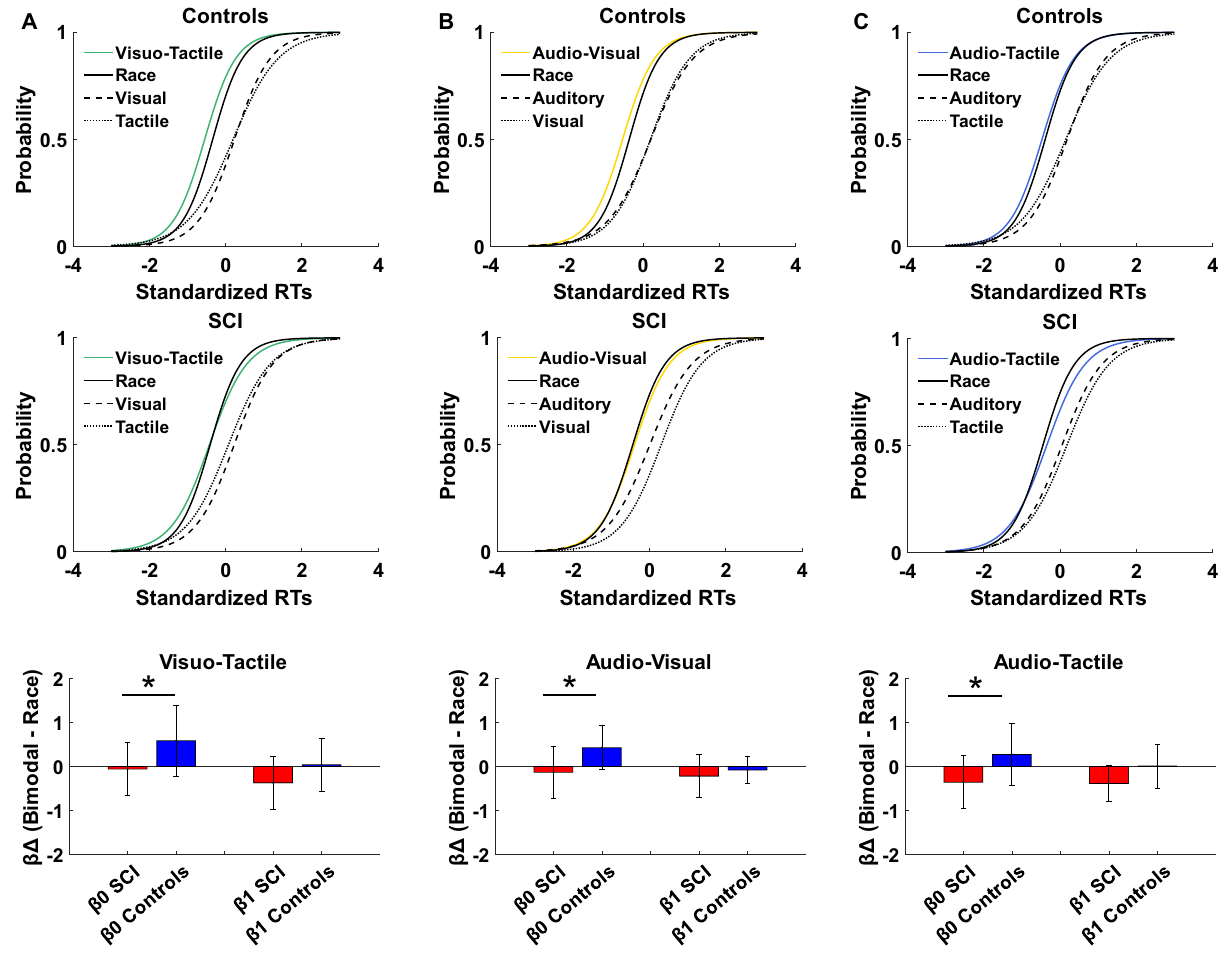
Figure 4. Logistic fit of the CDFs in healthy controls and SCI participants: Figure shows logistic fit in bimodal conditions ( A ): Visuo-Tactile: green line; ( B ): Audio-Visual: yellow line and ( C ): Audio-Tactile: light blue line) and race model (Race: black line). Unimodal conditions are represented by black dashed lines. Standardized RTs indicate z-scores. Bar plots (below each logistic fit and stimulus modality) indicate the difference (Δ) between bimodal and the correspondent race of the coefficients (β0: intercept and β1: slope expressed as log (odds)) in sci (red bars) and control subjects (blue bars). (Error bars indicate standard deviation).